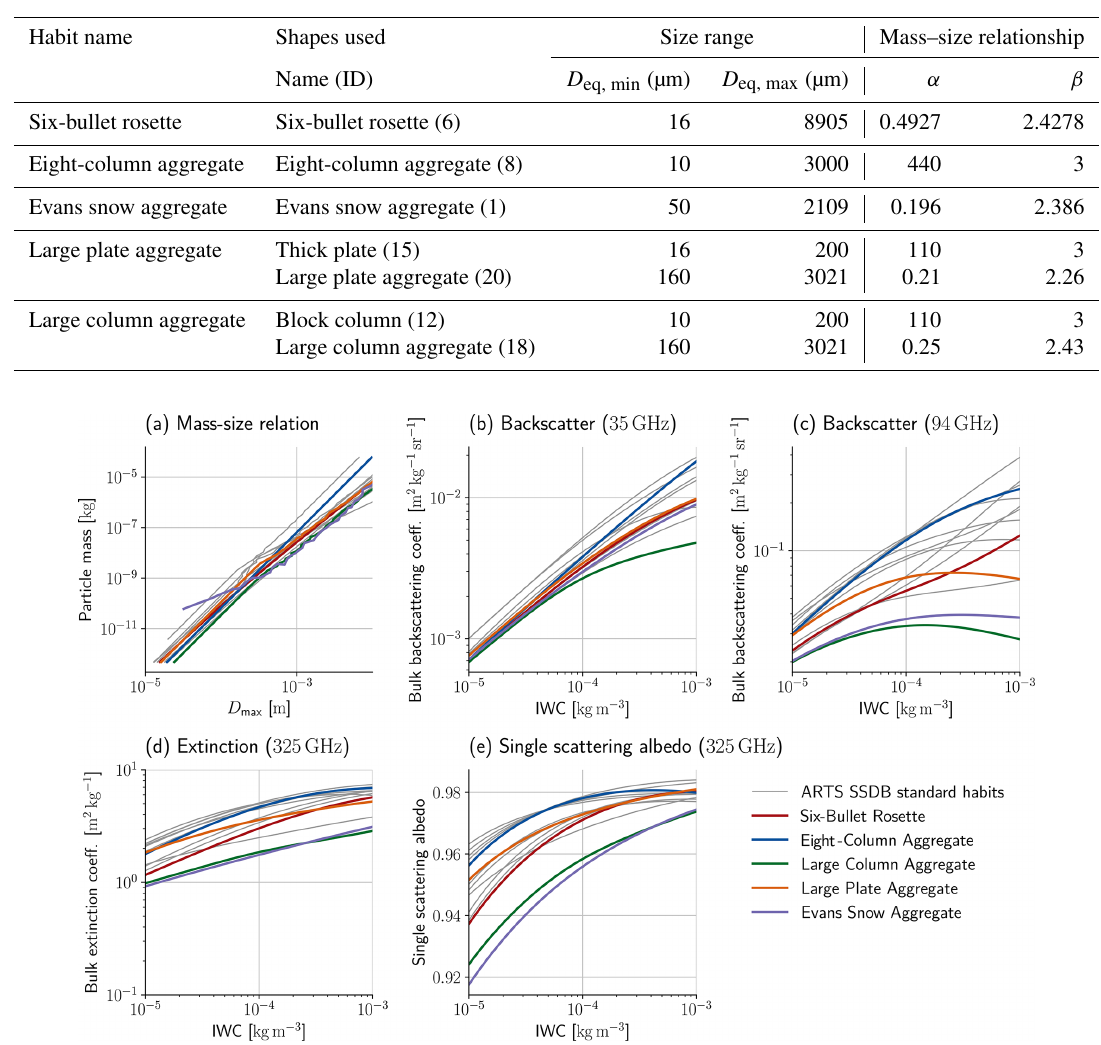
Figure 8. Properties of the selected ice particle shapes that are used to represent frozen hydrometeors in the retrieval forward model. Colored lines display the properties of the selected habits, while grey lines show the properties of the remaining standard habits distributed with the ARTS SSDB. Bulk optical properties were calculated using the PSD parametrization that is used in the